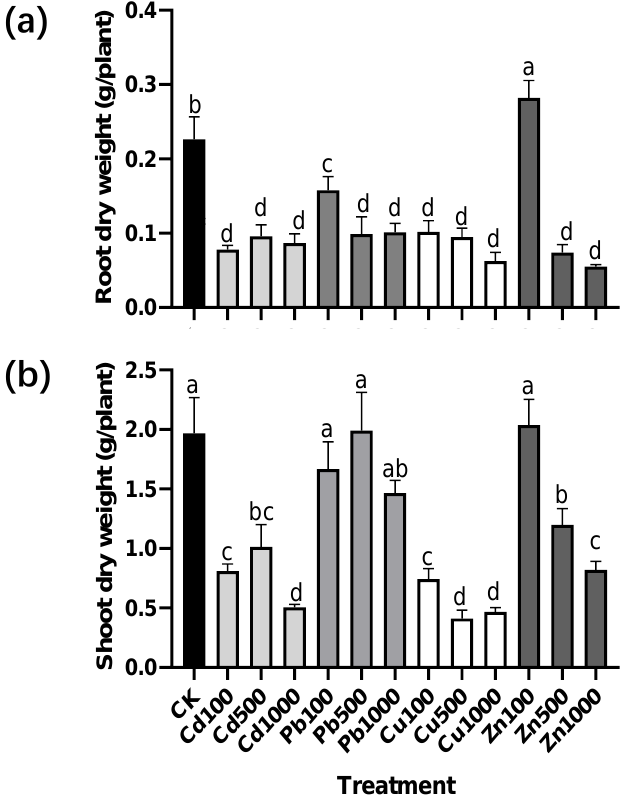
Figure 2. Dry weight of the roots ( a ) and shoots ( b ) of M. cordata under control (CK) and different concentrations of Cd, Pb, Cu, and Zn after 20 days of exposure. Values are means ± SEs ( n = 3) of three different experiments. Means denoted by different letters refer to the significant differences ( p < 0.05, Duncan’s test).